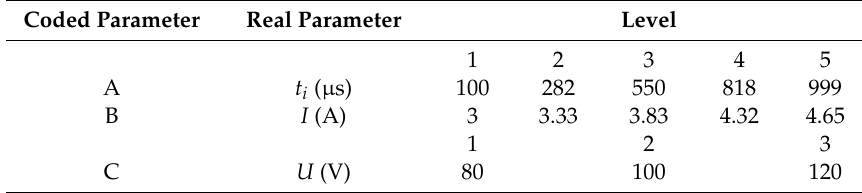
Table 4. The process parameters and their levels.